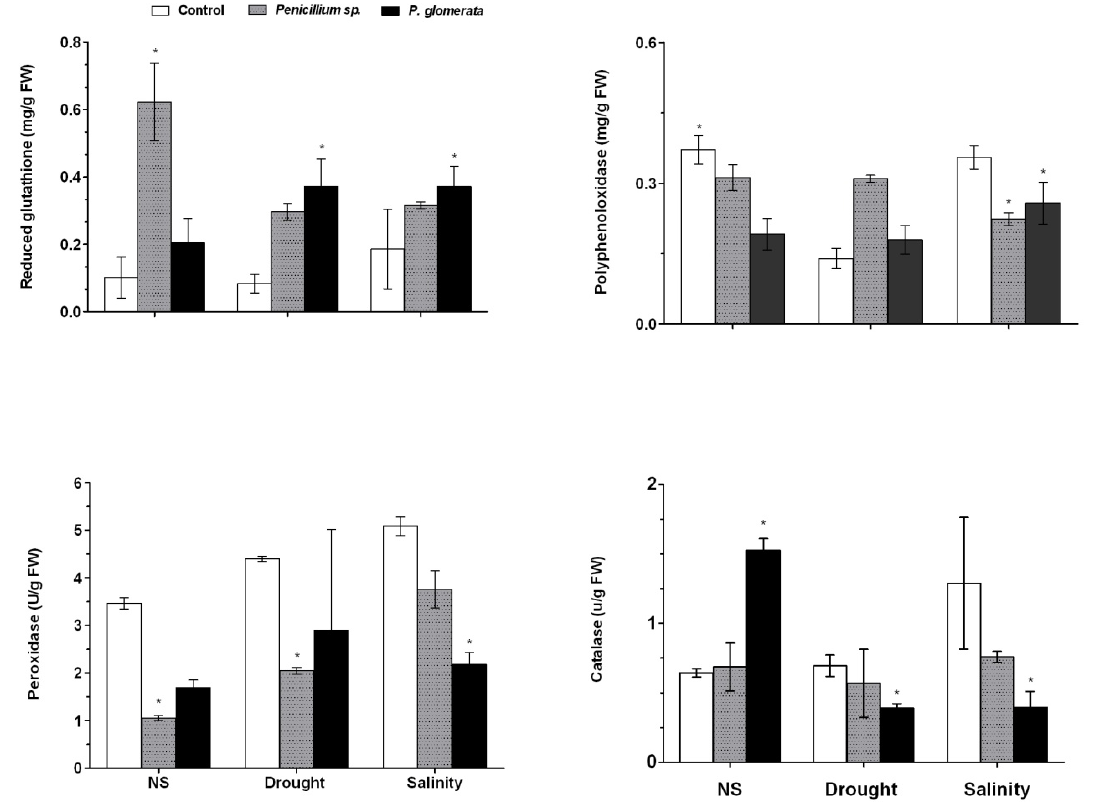
Figure 5. Effect of endophytic fungal association and abiotic stress treatment on the oxidative stress regulation. Antioxidants (reduced glutathione = GSH) and antioxidant enzymes (polyphenol oxidase = PPO; peroxidase = POD and catalase = CAT). Each value is the mean ± SD of three replicates per treatment. The ‘*’ indicates that values are significantly different from control ( p <